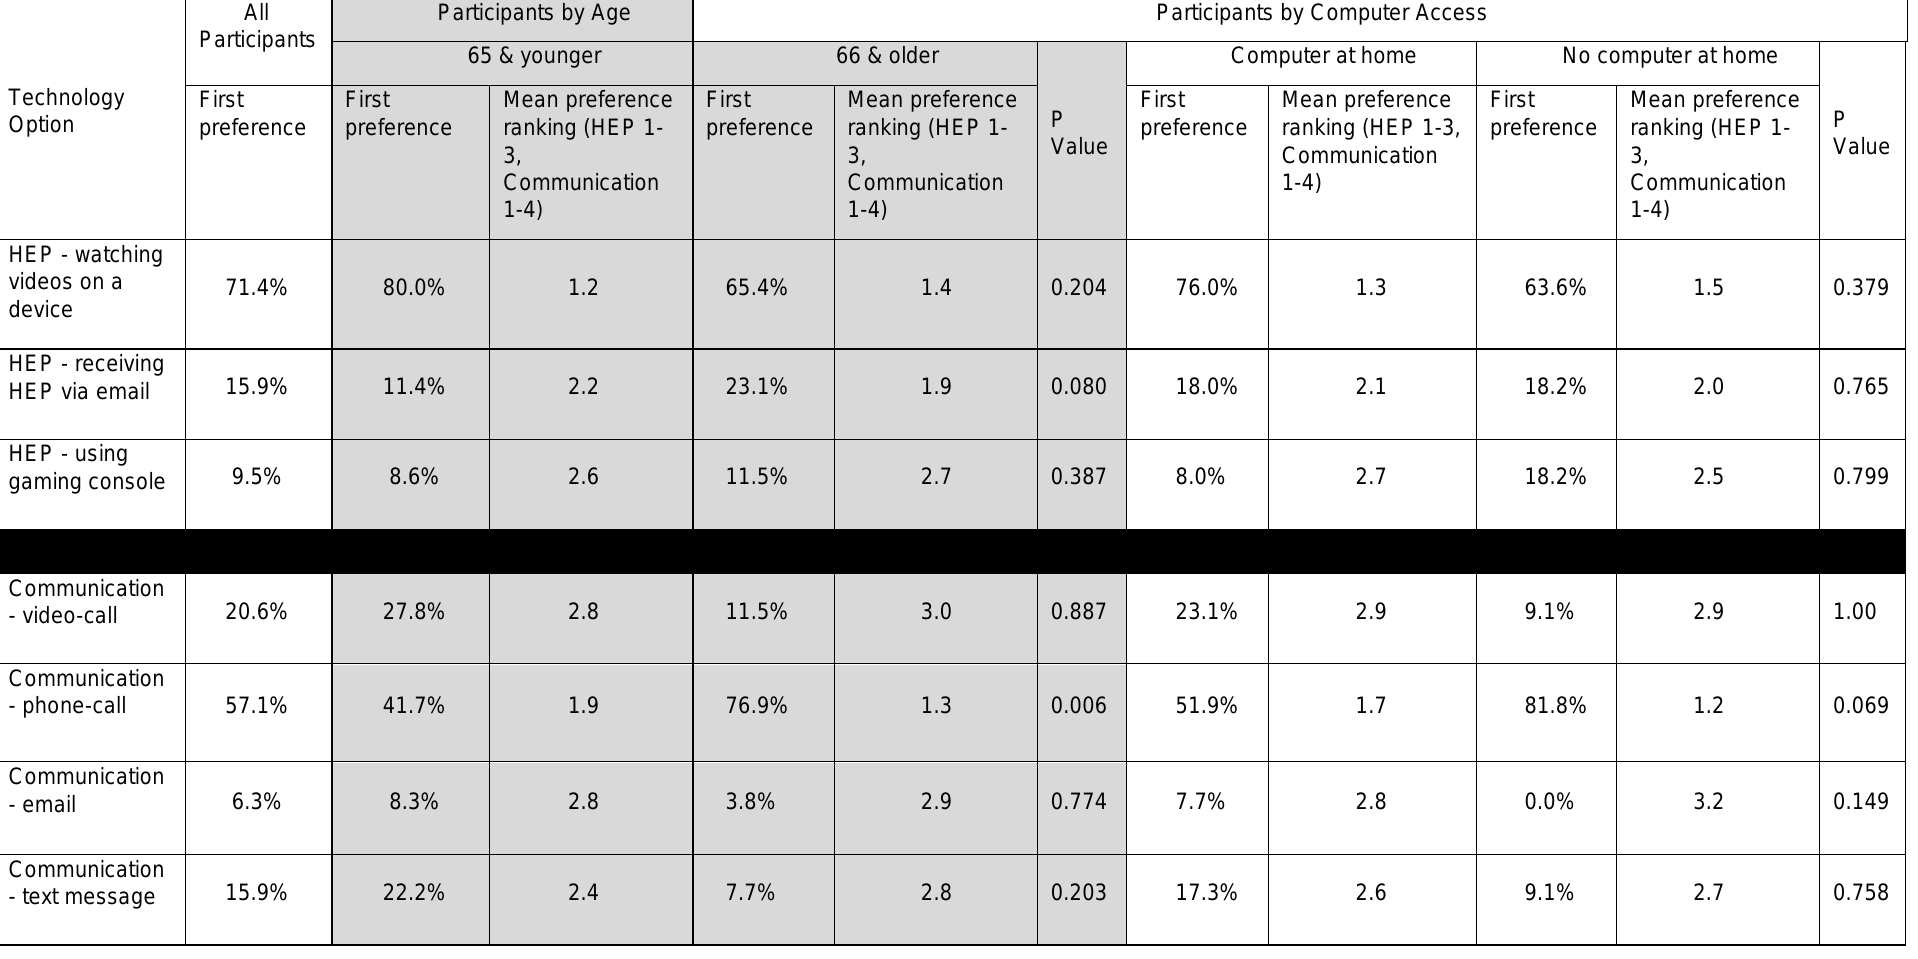
Table 2. Preferences for Using Technology to Facilitate HEP and Communicate with Physiotherapist